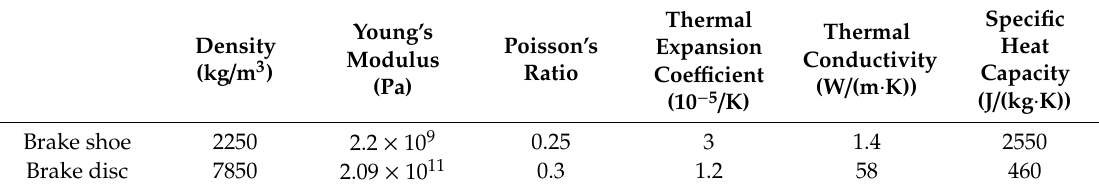
Table 3. Material parameters of brake disc and brake shoe